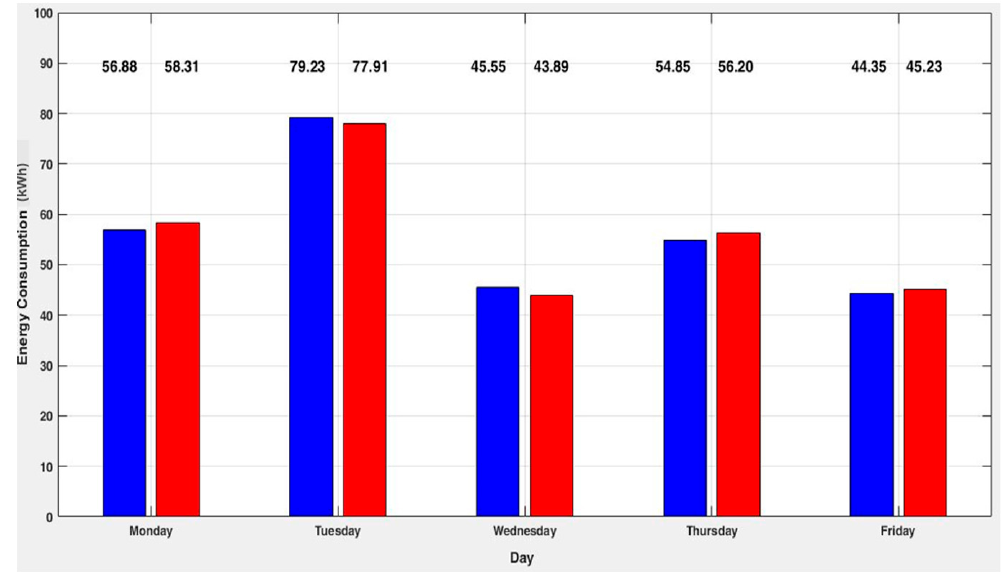
Figure 15. The comparison between the real (red) and forecasted (blue) energy consumptions. It can be observed that the percentage errors are in the range [1.95, 3.80], and the mean absolute percentage error calculated on the analysed period (a week) is 0.24%. These values can be considered very satisfactory for the Decision-Maker in the situation in which the evolution of the activities associated with the technological process is dynamic and uncertainties regarding the execution of specific operations, such as tinsmith and mechanical repairs for each programmed car, can occur. Details about the energy consumption forecasting for the day with the medium intensity of the activity, highlighted with bold in Table 9, are presented in Table 10, where the grey cells belong to the Decision-Making Matrix (DMM), and the signification of the rules associated with the expert system being: